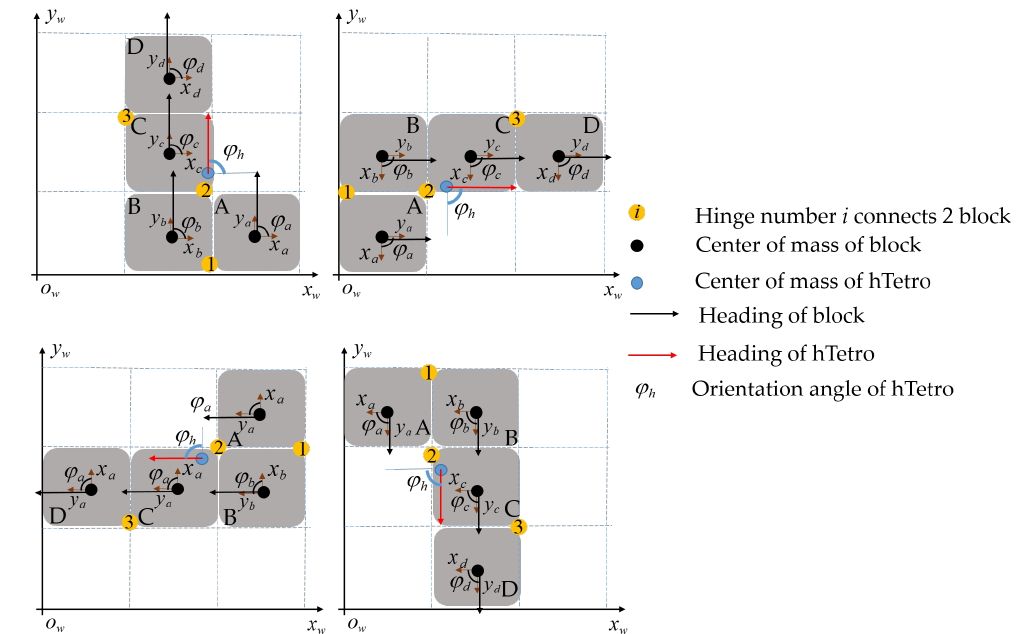
Figure 10. hTero on the workspace with respecting to the